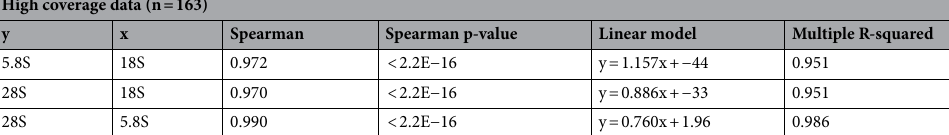
Table 6. Correlations between the three rRNA genes encoded in the 45S repeat unit in the subset of high- coverage 1000 Genomes Project data also analyzed in the low-coverage dataset. The Spearman correlation coefficient and linear models that describe the relationships between the 18S, 5.8S, and 28S copy numbers are shown.